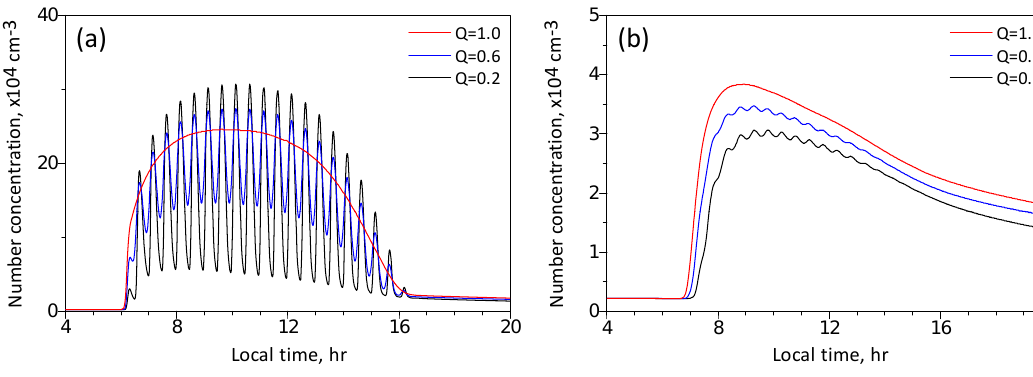
Fig. 6. Same as Fig. 4, but with the influence of stratocumulus cloud shadows.